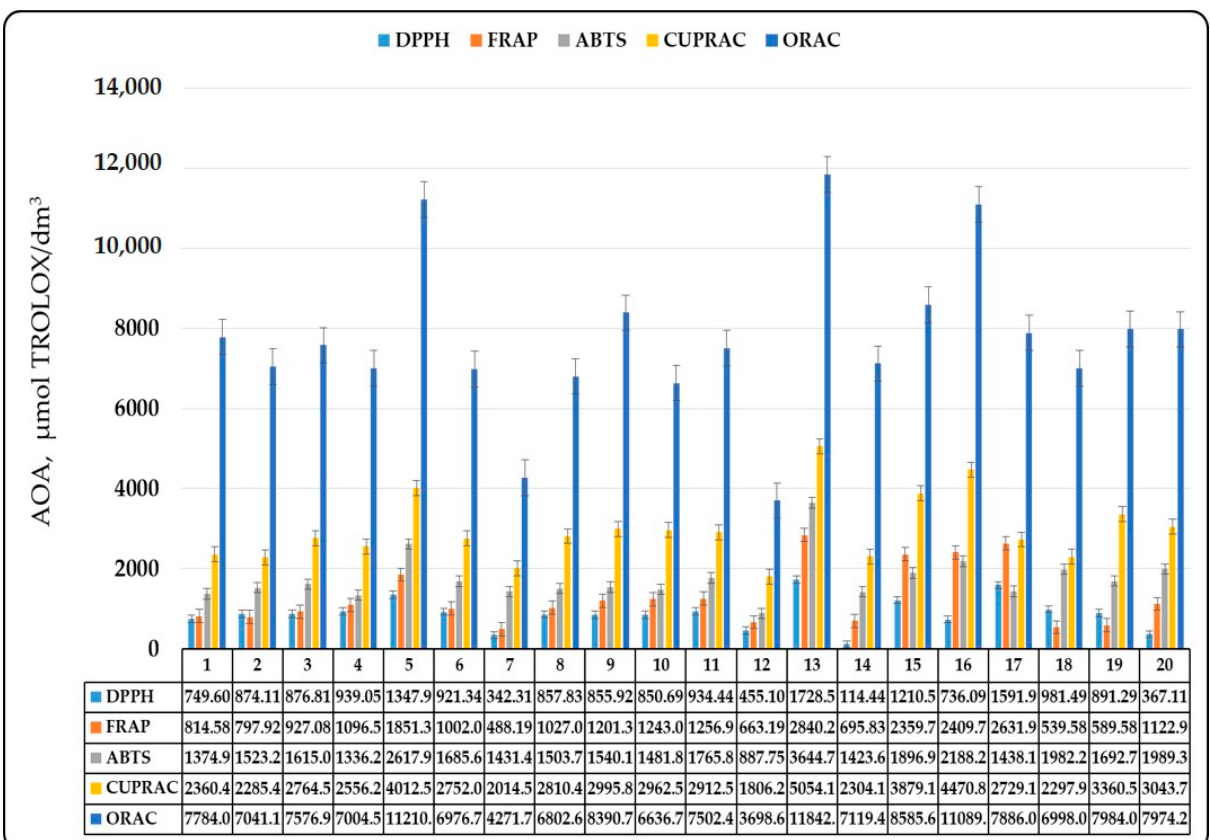
Figure 5. Antioxidant activity of malt. 1—Pilsen; 2—Pale ale; 3—Vienna malt; 4—Munich; 5—Melanoidine; 6—Munich dark; 7—Wheat; 8—Red X; 9—Caramel amber; 10—Caramel hell; 11—Black; 12—Caramel pils; 13—Special X; 14—Special Wheat; 15—Caramel Munich I; 16—Caramel Munich II; 17—Chocolate; 18—Rye; 19—Acidulated; 20—Smoked malt.